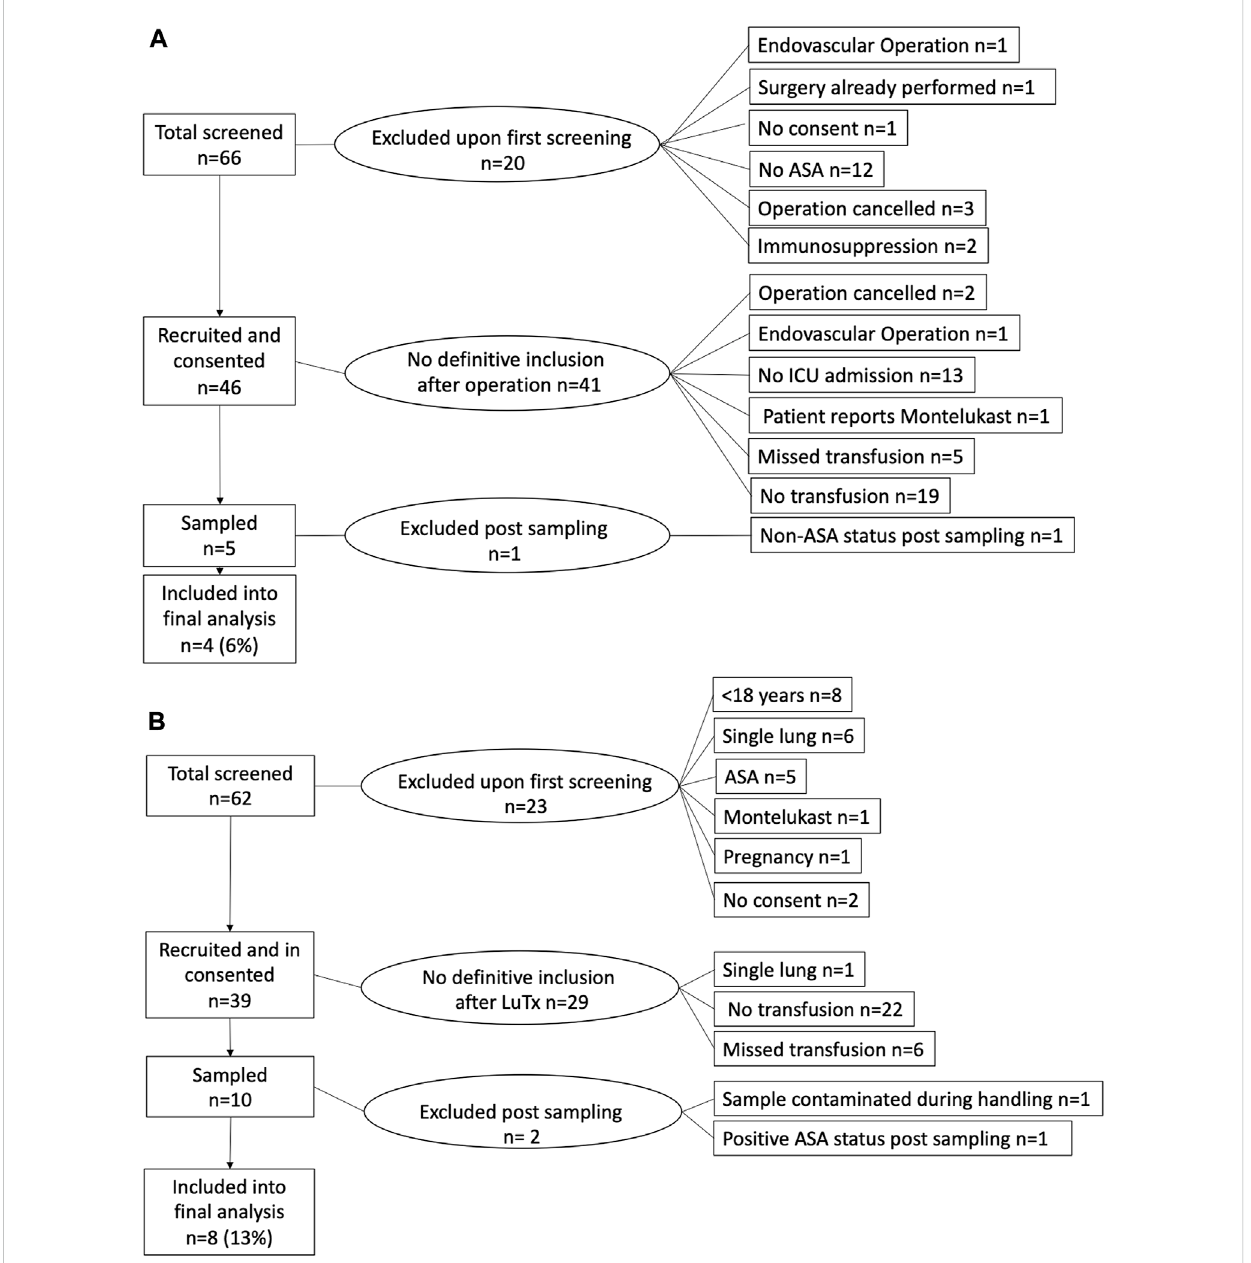
FIGURE 2 Flowcharts of patient recruitment. Patients scheduled for (A) aortic surgery or (B) bilateral lung transplantation were pre-screened, and informed consent was obtained before surgery. De fi nitive inclusion into the study was performed after surgery. In total, three patients had to be excluded